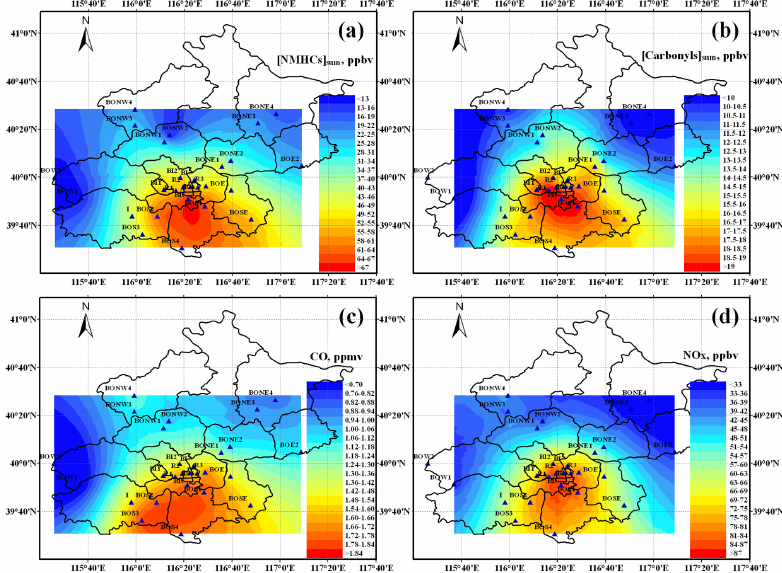
Figure 1. Contour maps of annual average mixing ratios of (a) total NMHCs, (b) total carbonyls, (c) CO, and (d) NO x at 27 sites in Beijing. Blue triangles indicate sampling locations. The names and typologies of these sites are listed in Supplement Table